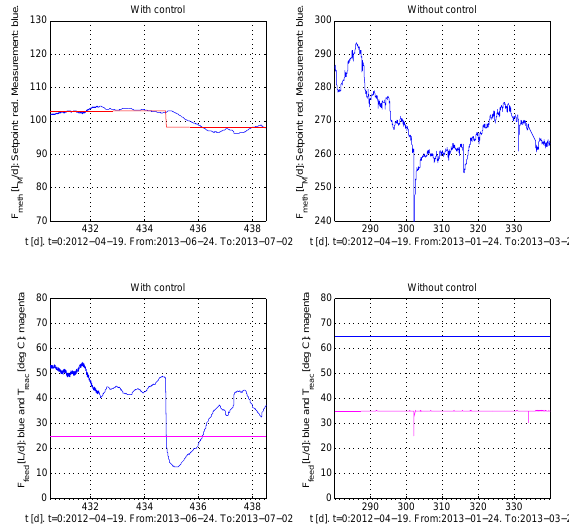
Figure 5: F meth and F feed , and T reac , for the real re- actor, with (automatic) control and without control. (The length of each of the time in- tervals for these two cases are different.)